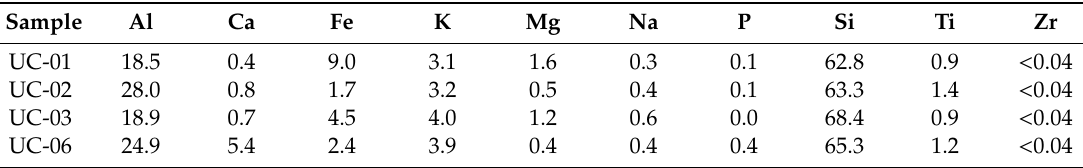
Table 4. Concentration of major cations as oxides (wt. %) in underclay